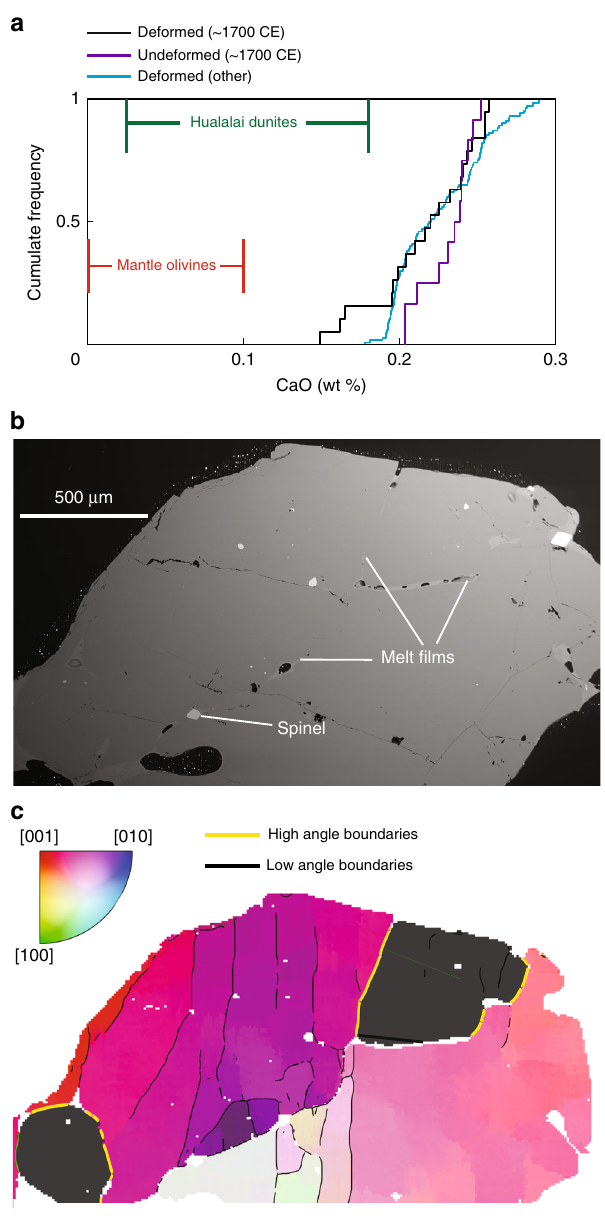
Fig. 6 Textural and chemical evolution during downslope fl ow. a CaO contents of deformed K ī lauean olivines (excluding the ~1700 eruption) plot well outside the fi eld for mantle olivines (see ref. 44 ), and have substantially higher CaO contents than olivines from Hualalai dunites (see ref. 15 ). Some deformed olivines from the ~1700 eruption have lower CaO contents than undeformed olivines in this sample. In fact, three deformed olivines fall within the compositional fi eld of Hualalai dunites. b Backscatter electron image showing prominent melt fi lms along high angle boundaries (yellow lines on c ) in the interior of a deformed crystal from the ~1700 eruption. c Electron backscatter diffraction (EBSD) map colored with the inverse pole fi gure (IPF) color key scaled to 10° about the mean orientation of the central grain. High angle boundaries (misorientation angle >10°) are colored yellow, and low angle (subgrain) boundaries (misorientation angle <10°) are colored black. Scale for both images shown on the backscatter